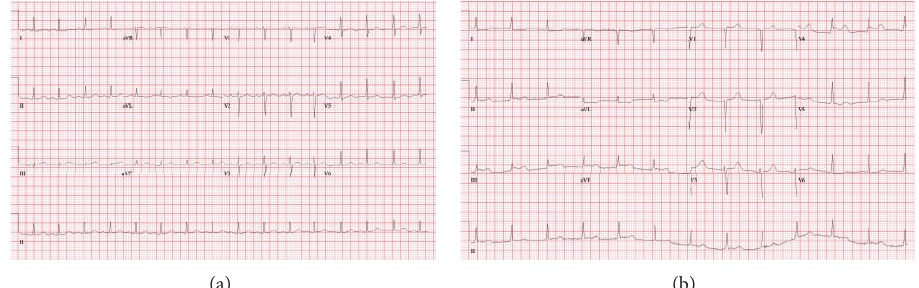
Figure 1: Electrocardiograms: (a) at baseline; (b) after chest pain onset.